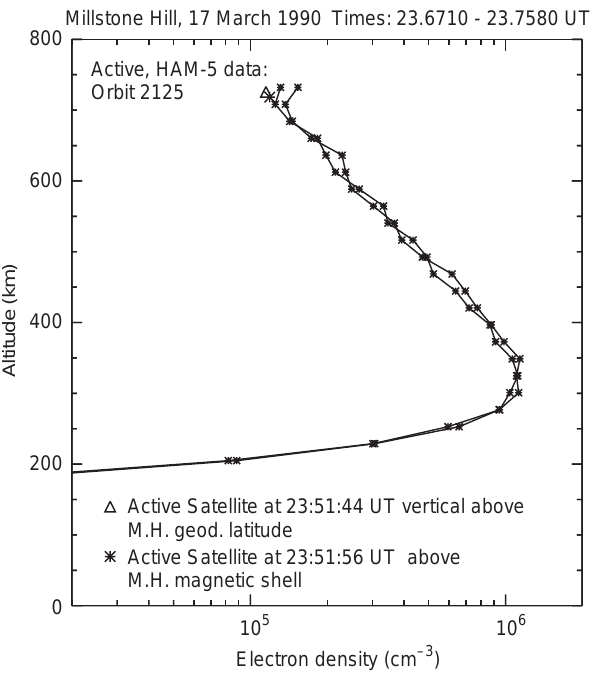
Fig. 3. Direct comparison of electron density measurements of the HAM-5 probe onboard the Active satellite with the measured Millstone Hill N e radar profile for the direct overflight during orbit 2125 on March 17, 1990, a geomagnetically quiet